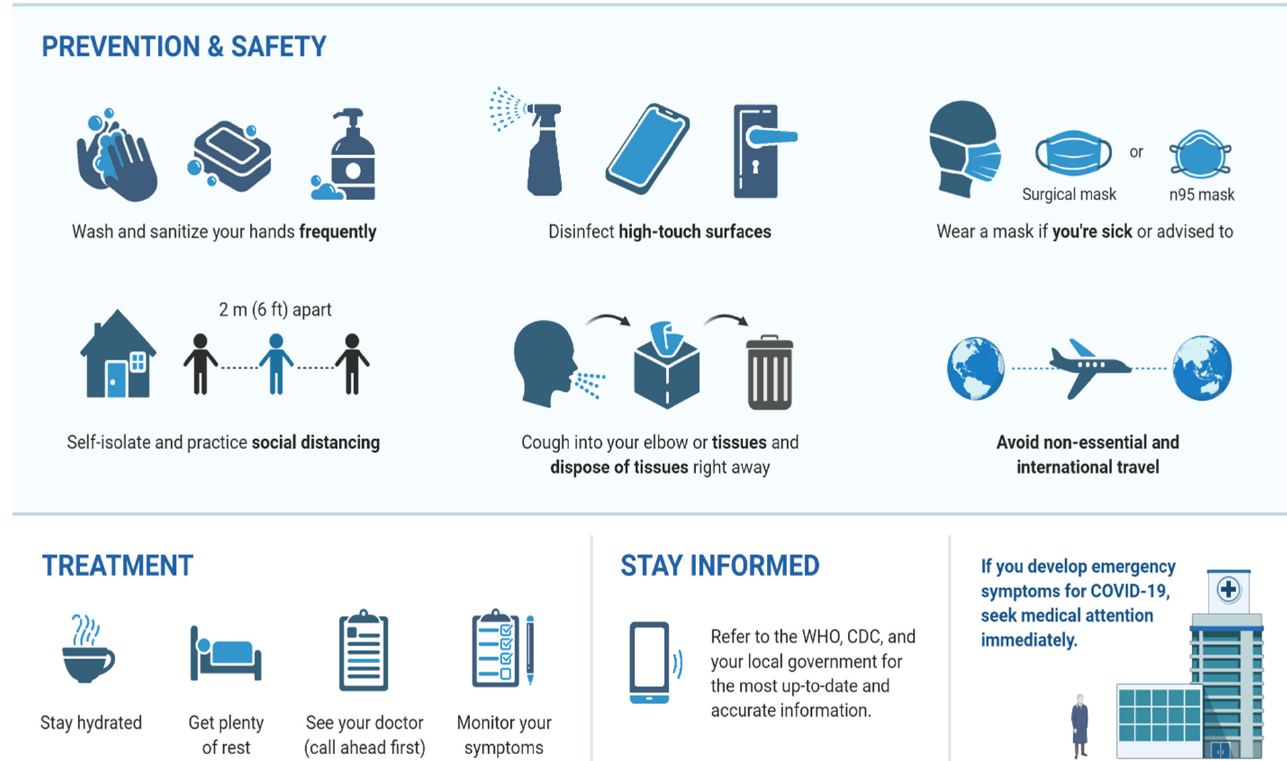
Figure 5. Prevention and safety protocol to avoid COVID-19.